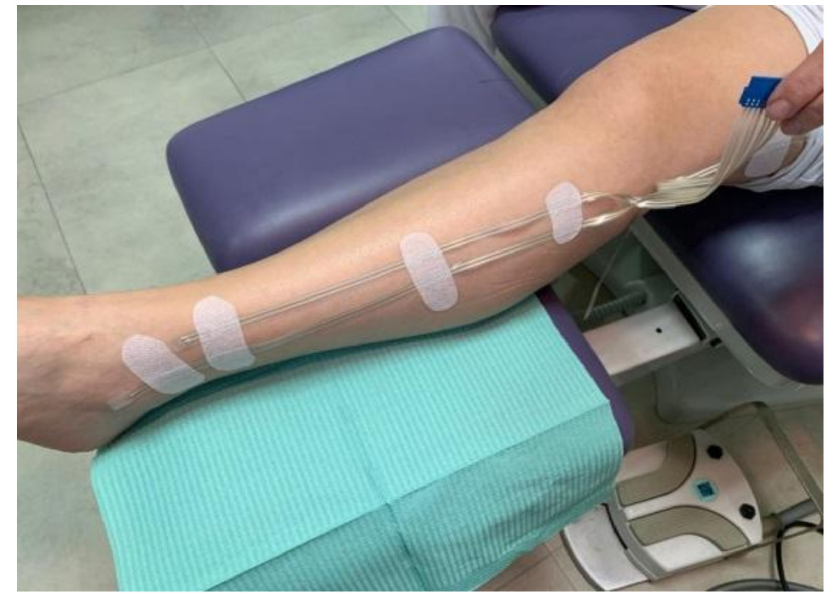
Figure 18. Placement of the system along the